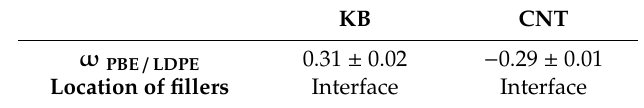
Table 8. Wettability coe ffi cient and predicted location of fillers in conducting LDPE / PBE